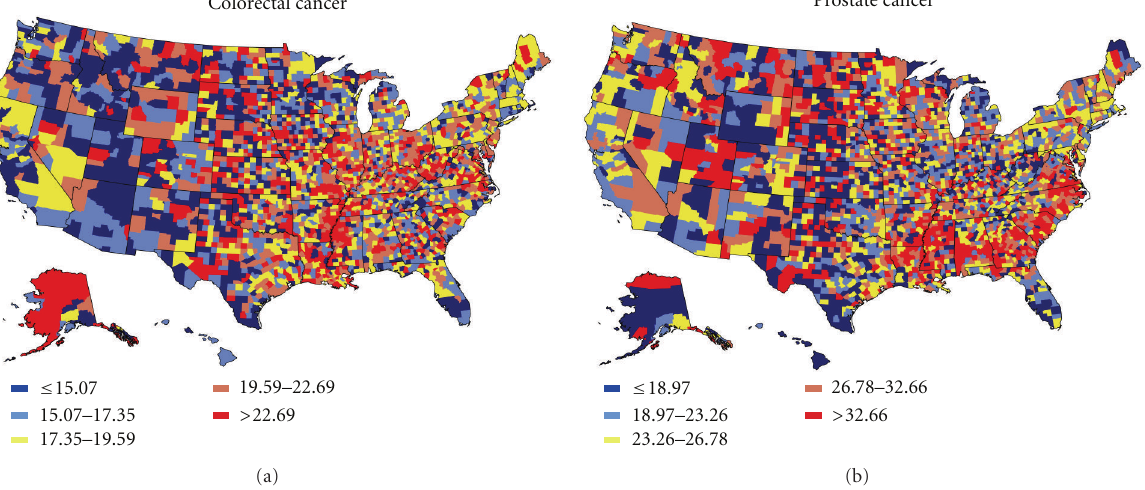
Figure 4: Colorectal and prostate cancer mortality rates per 100,000 population (age adjusted to the 2000 population), United States, 2003– 2007 (3,141